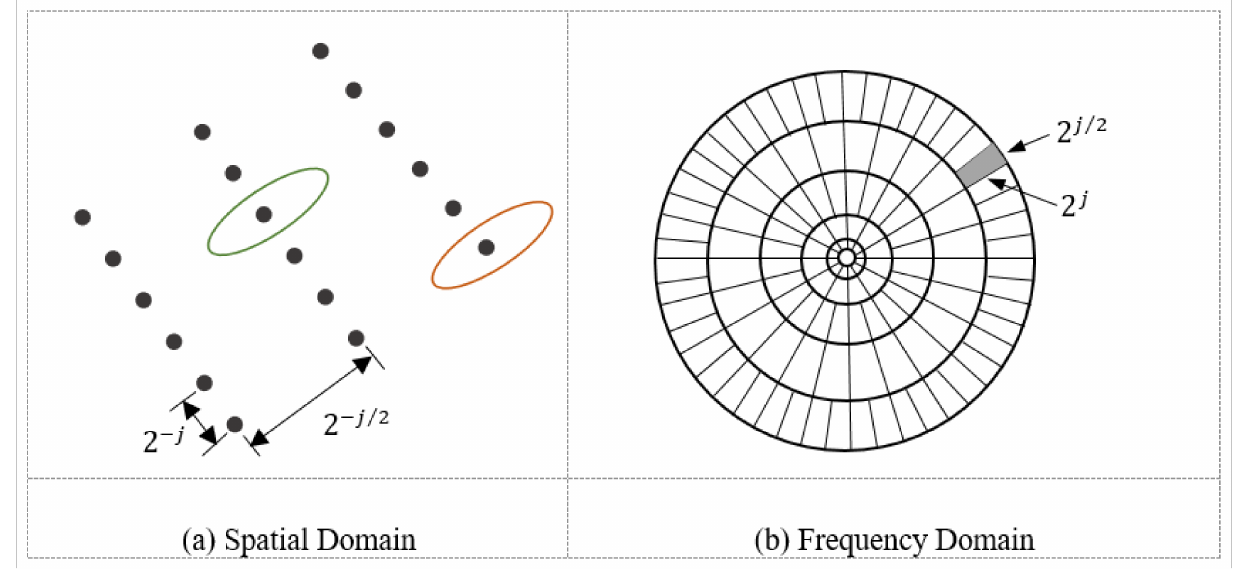
Figure 6. Curvelet Transform Domain.